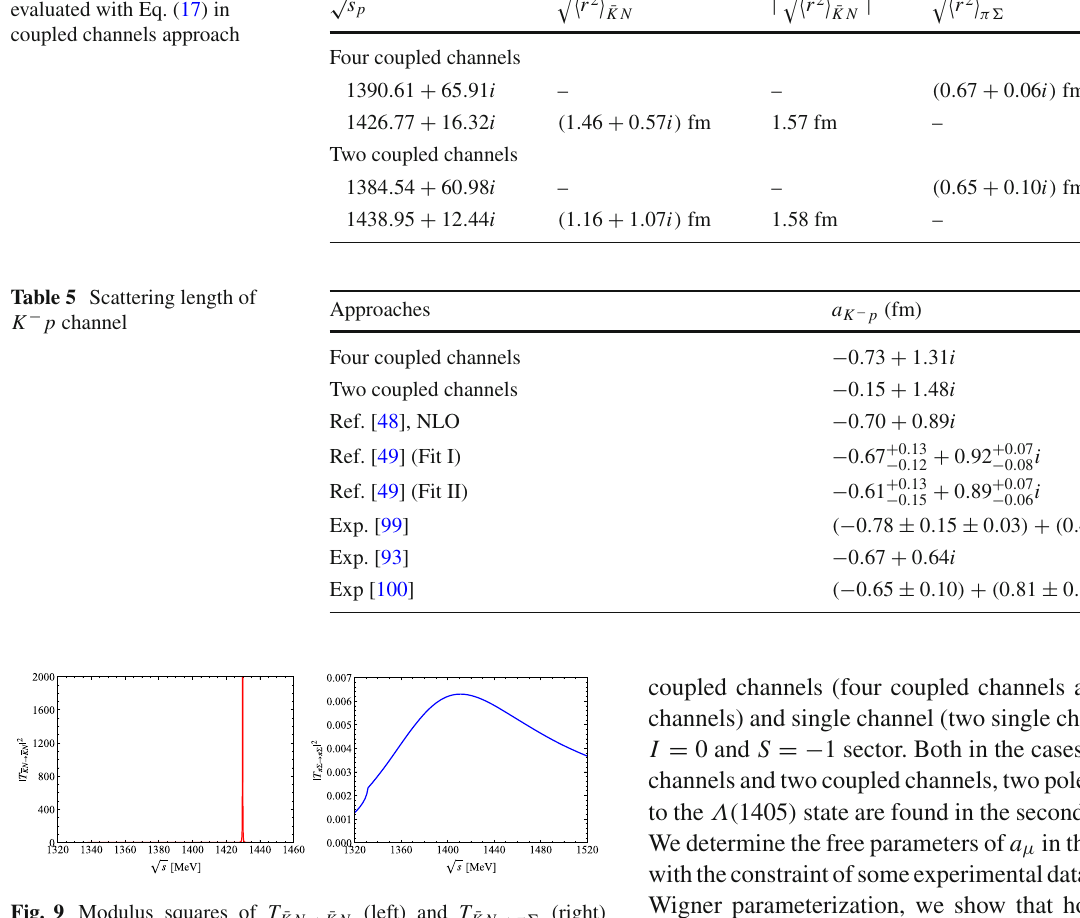
(left) and T ¯ (right) KN → ¯ KN KN → π(cid:4)